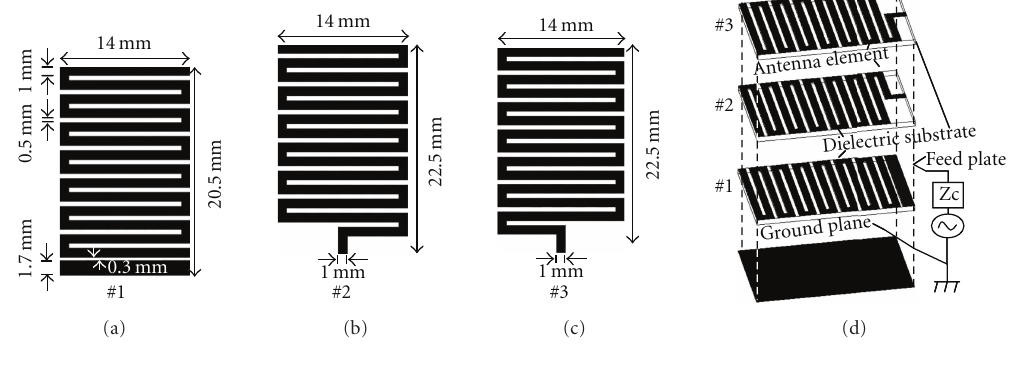
Figure 8: Dismantled structure of the 3L-CFMA